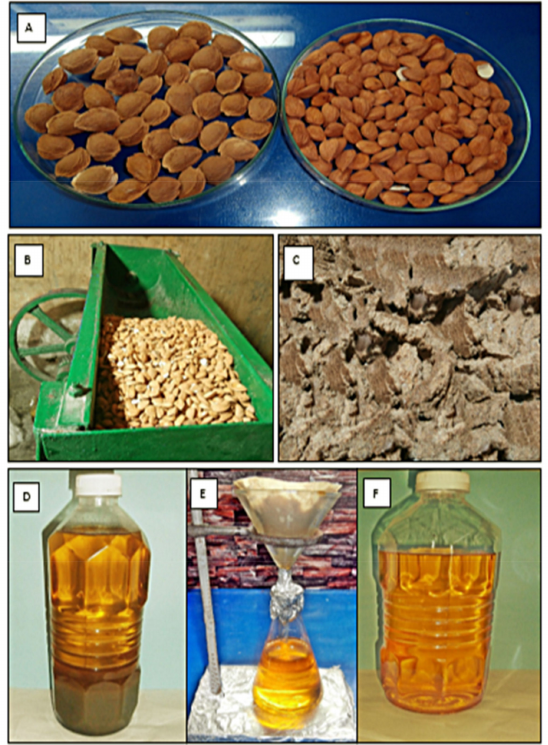
Figure 2. ( A – F ). ( A ) Shelled and deshelled seeds of Prunus aitchisonii . ( B ) Seeds in oil expeller. ( C ) Oil cake. ( D ) Crude oil. ( E ) Crude oil filtration. ( F ) Filtered pure